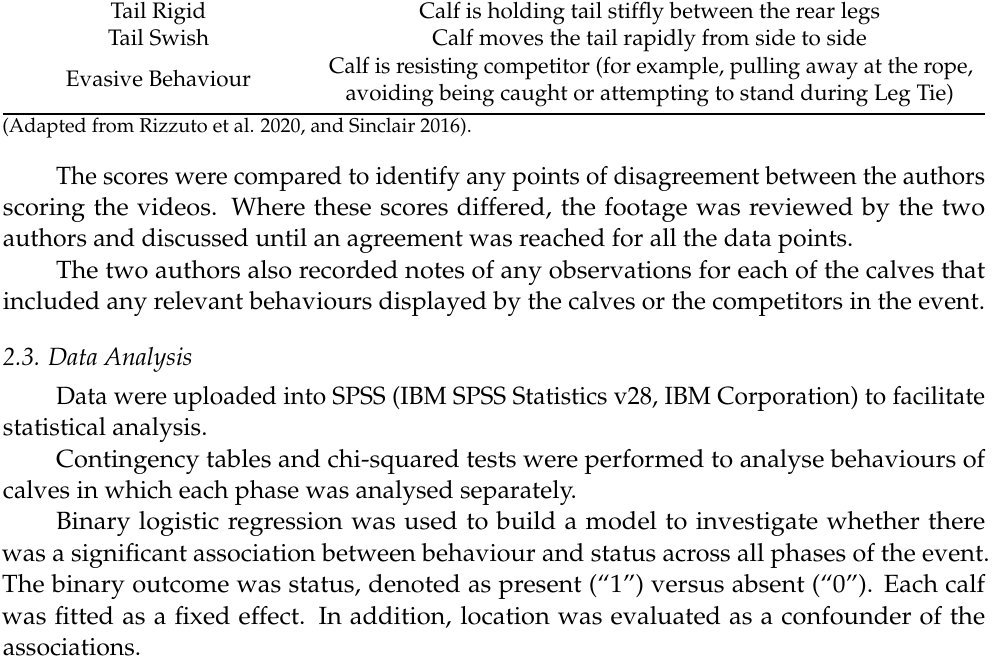
Table 3. Descriptions of behaviours used by observers for behaviour scoring in rodeo calves. Behaviour Description Ears Axial Ears are perpendicular to the side of the head Ears Back/down Ears are pointed towards the back of the animal Eye White Increase in the amount of sclera of the eye that is visible Vocalisation Calf emits noise from mouth Leg Movement—Fast Calf is running at full speed Leg Movement—Slow Calf is walking or slowly trotting Tail Relaxed Tail is free to move and swish Tail Rigid Calf is holding tail stiffly between the rear legs Tail Swish Calf moves the tail rapidly from side to side Calf is resisting competitor (for example, pulling away at the rope, Evasive Behaviour avoiding being caught or attempting to stand during Leg